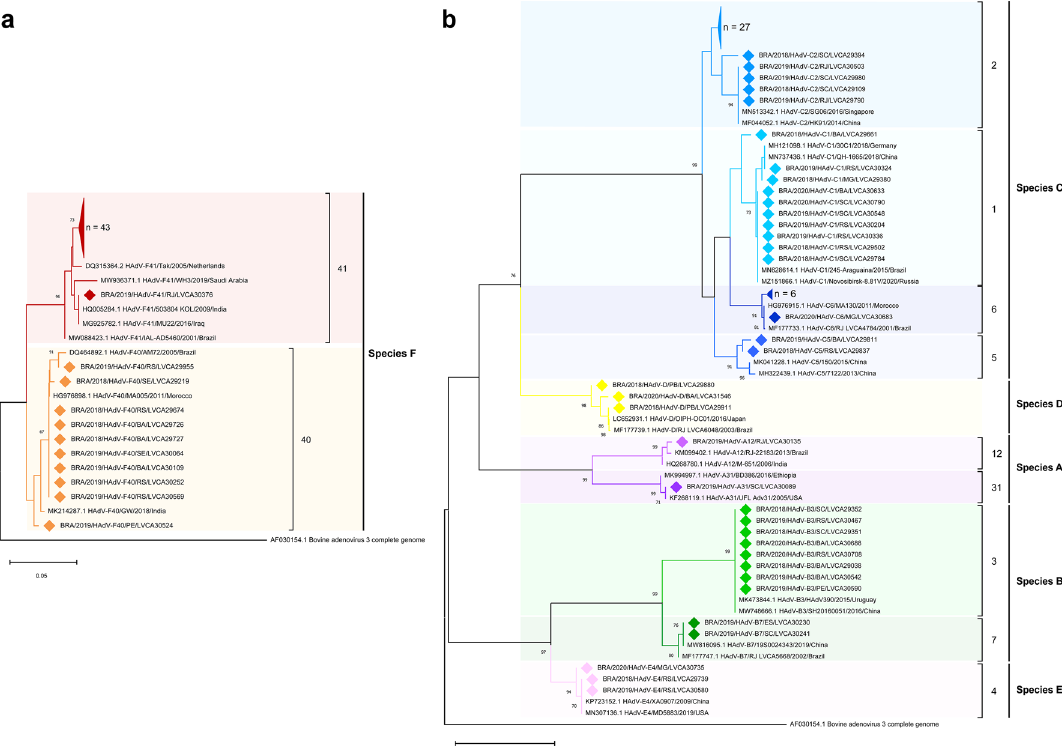
Figure 2. Phylogenetic analyses based on a conserved region of the hexon gene nucleotide (nt) sequence (located at positions 21–322, upstream of the surface loop l 1 ) of the circulating Brazilian (a) enteric and (b) non-enteric Human Adenovirus (HAdV) types. Reference strains were downloaded from GenBank and labeled with their accession number followed by type, register number, year and country. Strains obtained (marked with a diamond) are shown as per country followed by type, year of collection, state and the LVCA internal register number (i.e., BRA/2019/HAdV-C2/RJ/LVCA30503). Neighbour-joining phylogenetic tree was constructed with MEGA X software and bootstrap tests (2000 replicates) based on the Kimura two-parameter model. Bootstrap values above 60% are given at branch